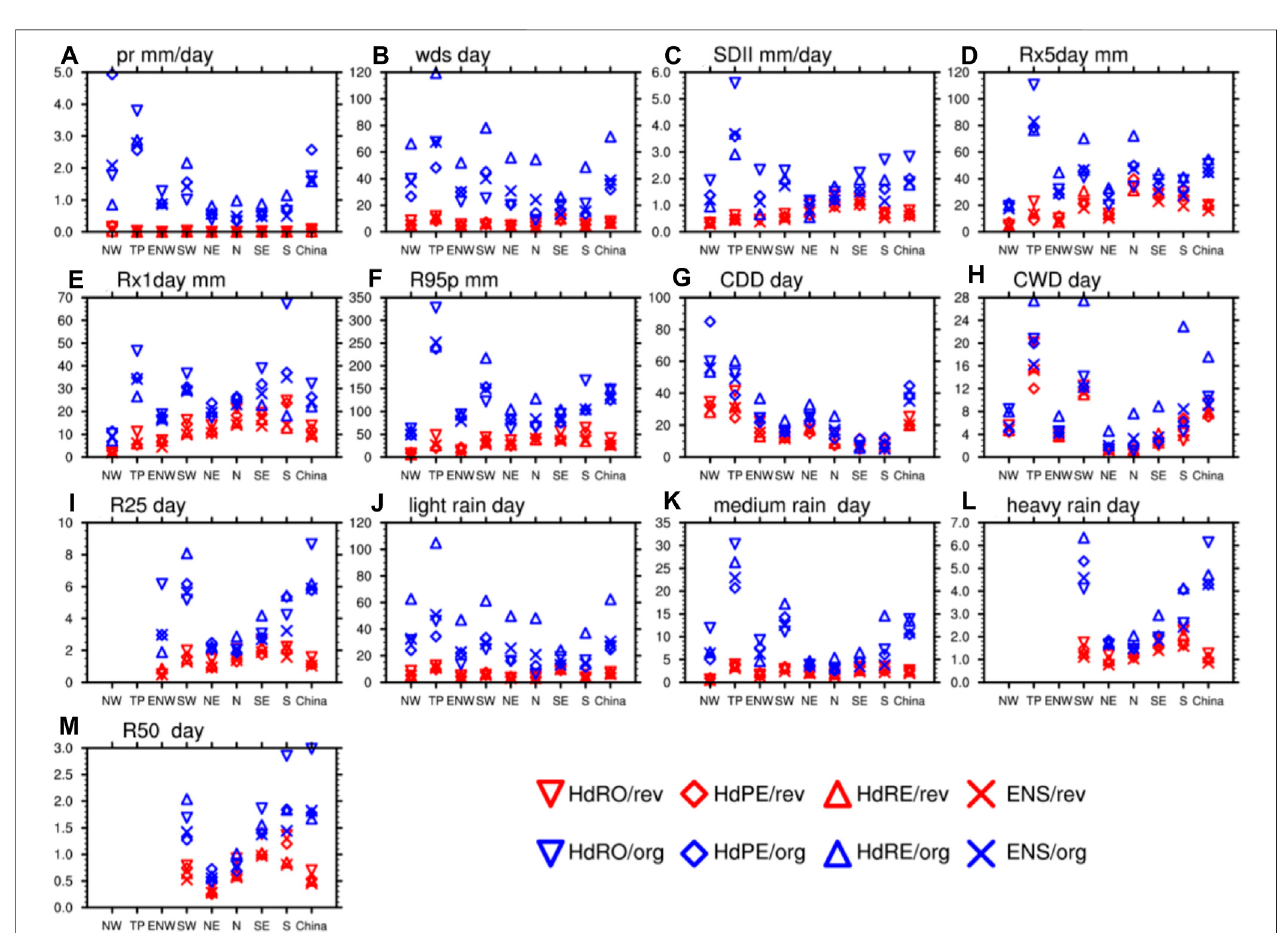
FIGURE6| RMSEofmeanprecipitation (A – C) ,extremeprecipitation (D – F) ,droughtindexes (G,H) andprecipitationdays (I – M) beforeandaftercorrectionineight sub-regions and China.